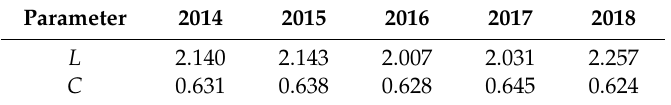
Table 5. The average path length and aggregation coe ffi cient of the networks during